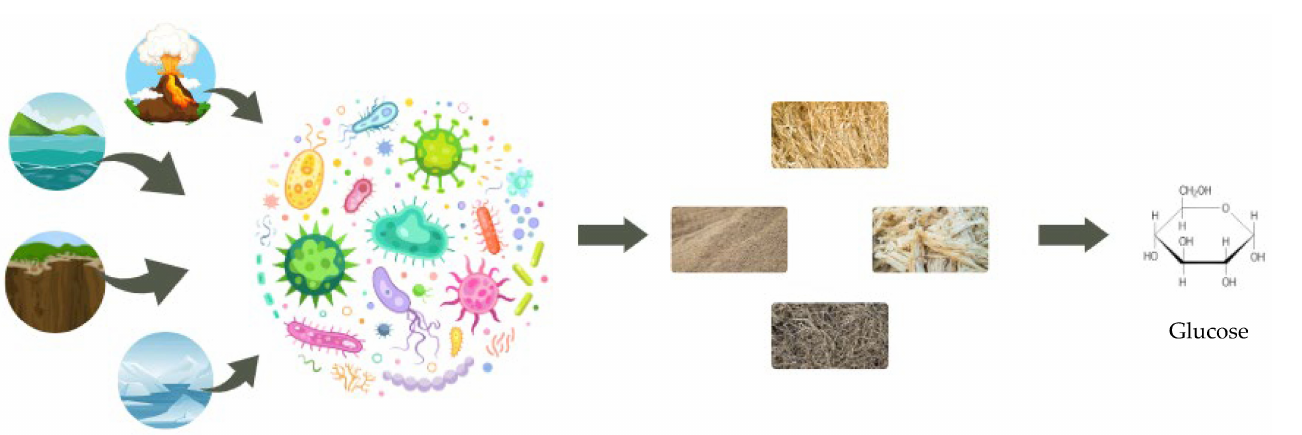
Figure 1. Microorganisms from the most diverse habitats are able, through the production of ligno- cellulolytic enzymes, to degrade various types of biomasses such as rice straw, corn straw, sugarcane bagasse, and soybean straw. From this, fermentable sugars are formed, exemplified here by glucose, which has a wide range of industrial applications.